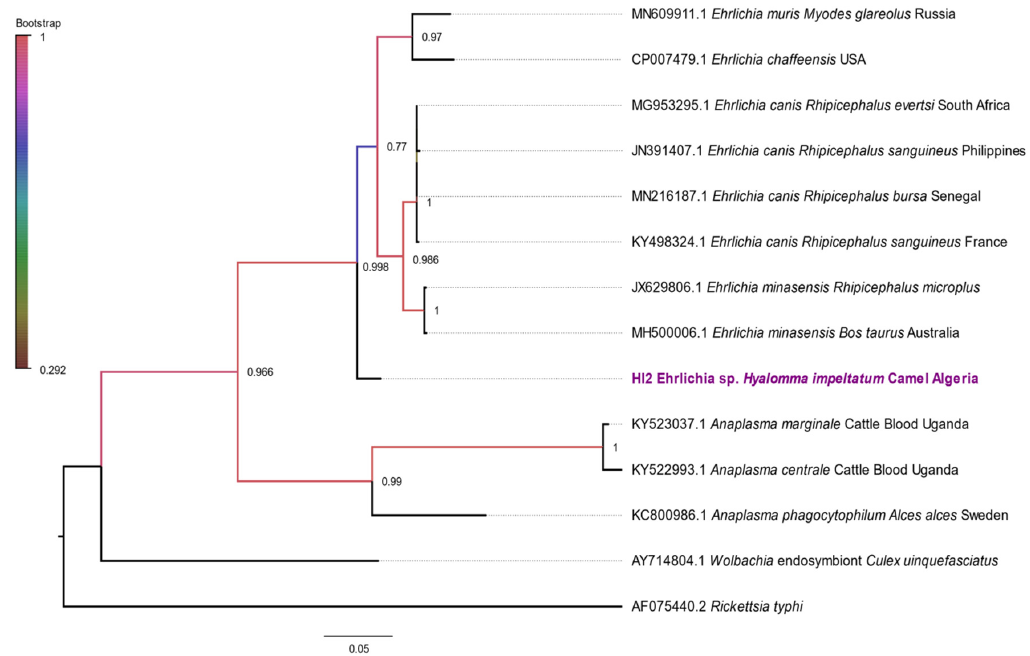
Figure 7. Phylogenetic tree based on groEL sequences aligned with MEGA 7 using Tamura 3-parameter model. Statistical support for internal branches of the trees was evaluated by bootstrapping with 500 iterations. Rickettsia typhi was added as an outgroup.